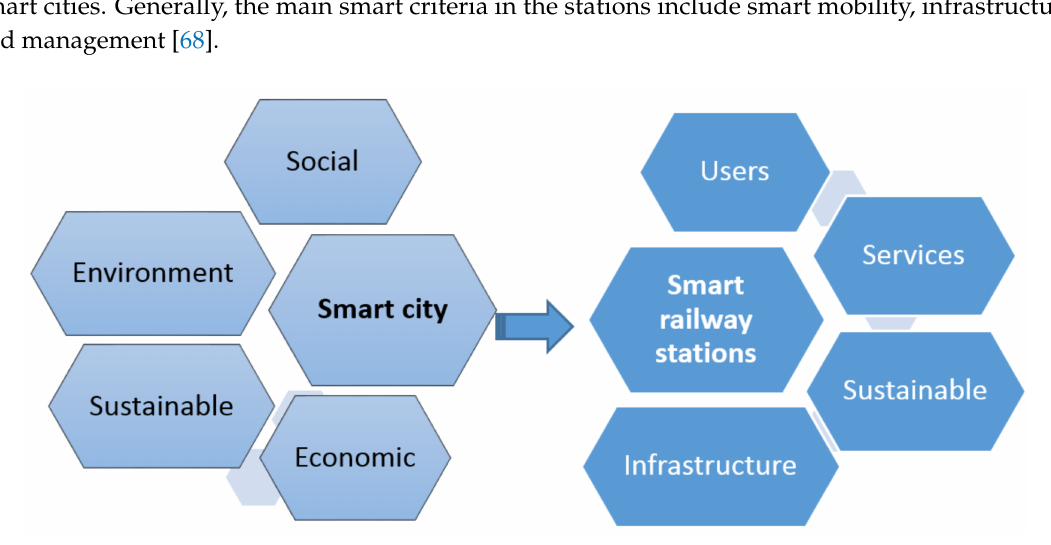
Figure 5. The concept of converting from smart cities to applying to railway stations